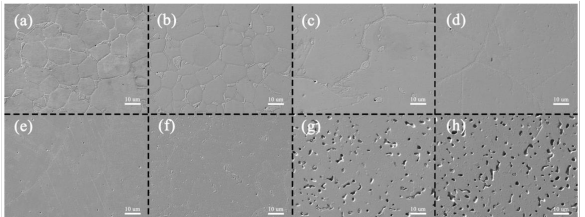
Figure 3. SEM images of heat-treated novel nitrogen-free austenitic stainless steel samples with the addition of ( a ) 0 ppm, ( b ) 500 ppm, ( c ) 750 ppm, ( d ) 1000 ppm, ( e ) 1500 ppm, ( f ) 2000 ppm, ( g ) 3000 ppm, and ( h ) 5000 ppm graphite.